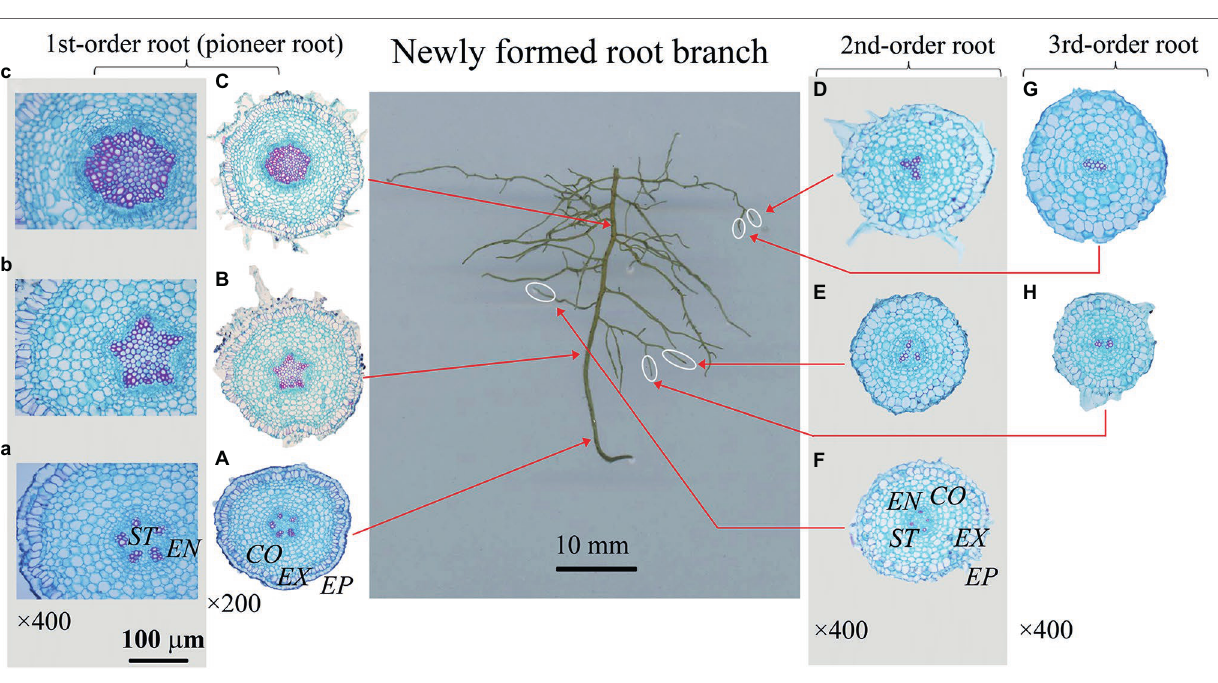
FIGURE 3 | Protoxylem group (PG) arrangement along root developmental order of Fraxinus mandshurica under control. There were five protoxylem groups (PGs; A,B ) in first-order root, four (F) and three (D,E) PGs in second-order roots, and two PGs (G,H) in third-order roots. The nature of PG in first-order root was obvious in primary growth (A,B) , but lost in the secondary growth (C) . EP , epidermis; EX , exodermis; CO , cortex; EN, endodermis; ST ,